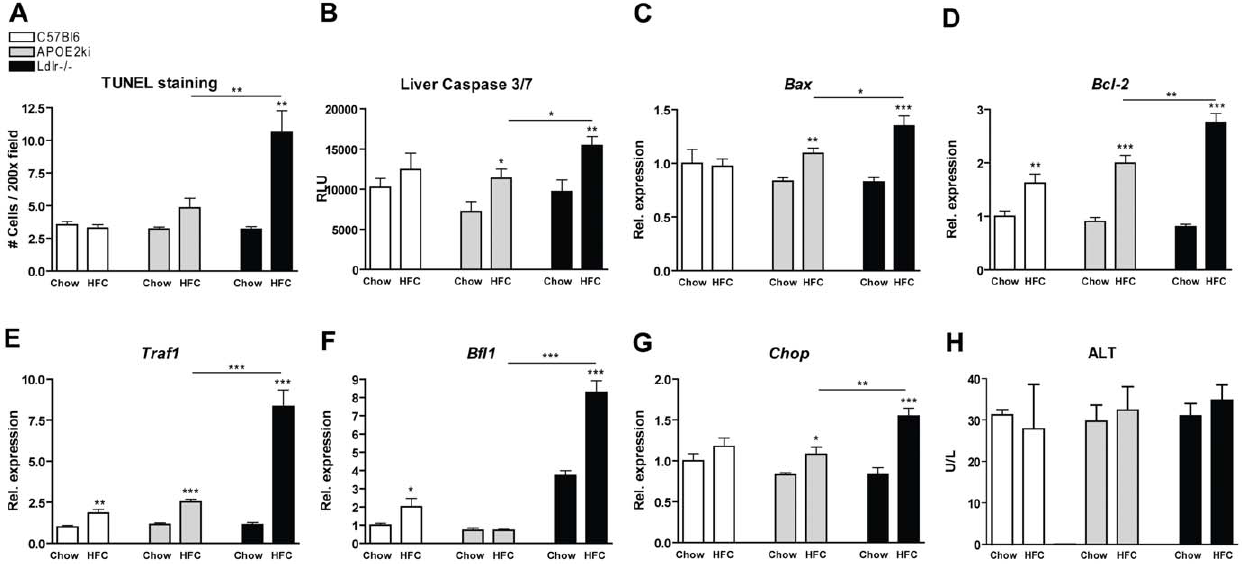
Figure 4. Parameters of apoptosis. (A) Scoring of TUNEL stained liver sections for apoptosis after chow and 3 months of HFC diet in C57Bl6, APOE2ki and Ldlr 2 / 2 mice. (B) Caspase 3/7 activity in liver homogenates. (C–G) Gene expression analysis of the apoptotic genes Bax , Bcl-2 , Traf1 , Bfl1 and Chop . (H) Aminotransferase (ALT) levels in plasma. Data were set relative to the C57Bl6 mice on the chow diet. * Significantly different from chow group. *, ** and *** indicate p , 0.05, 0.01 and 0.001, respectively.